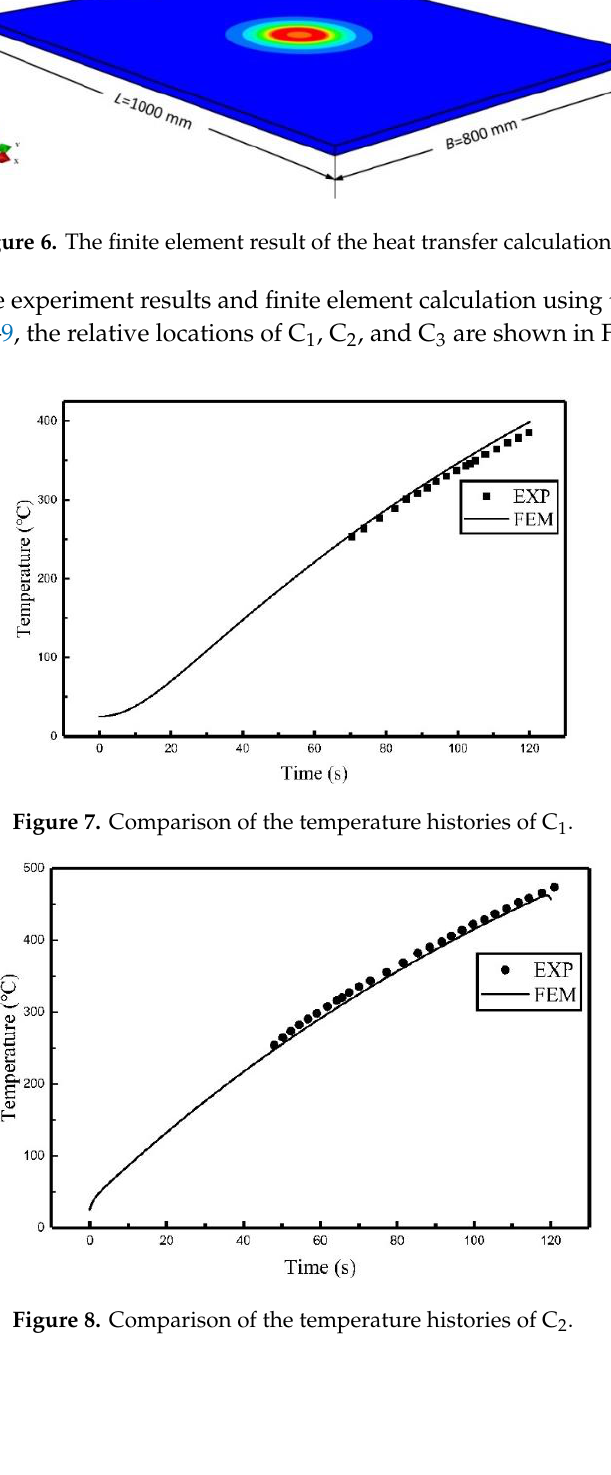
Figure 9. Comparison of the temperature histories of C 3 . It can be seen from Figures 7 – 9 that the temperature histories obtained using the heat source model for calculation are in agreement with the experiment results. Table 3 summarized the relative error between simulated results and experimental results. It can be seen that the maximum relative error was 5.42% and the average relative error was 3.64%. The comparison indicates that the temperature field of induction heating can be accurately simulated using a heat source model.